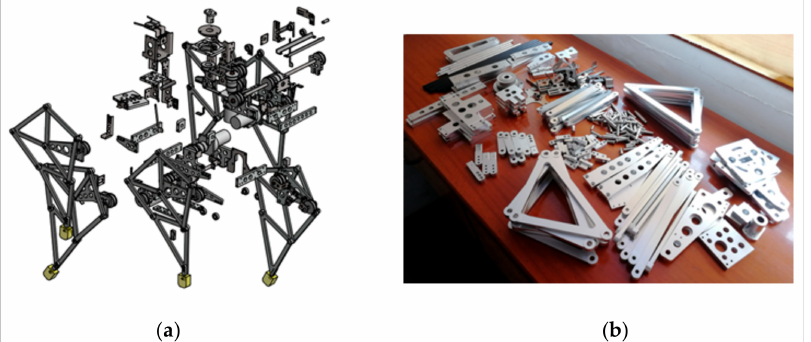
Figure 1. ( a ) Assembly drawing. ( b ) Mechanical components.